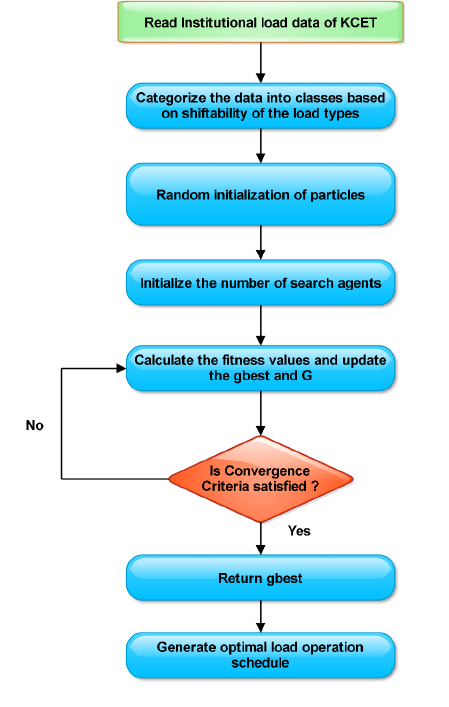
Figure 4. Flow diagram of the proposed methodology.